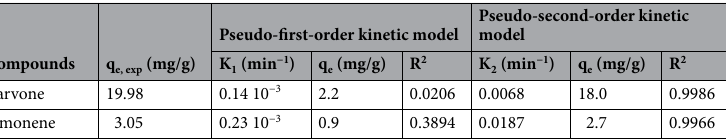
Pseudo-first-order kinetic model